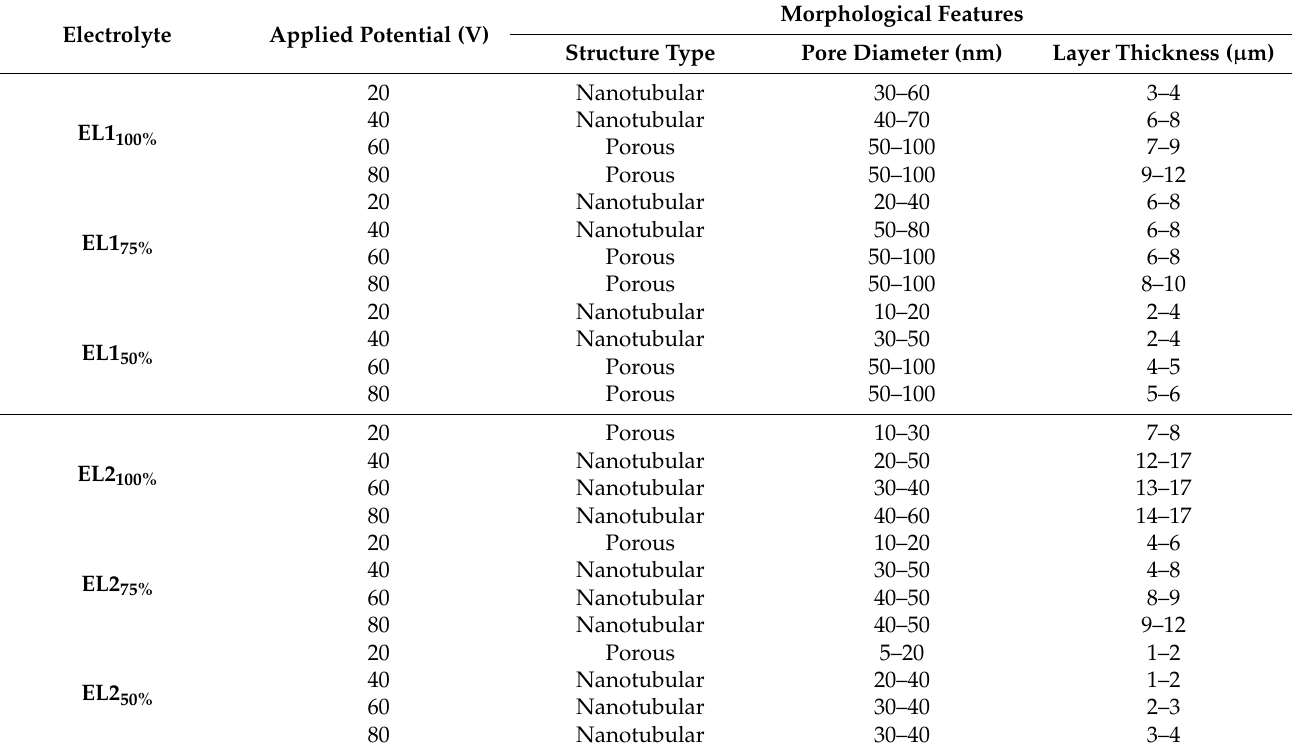
Table 2. Morphological features of the prepared TNS in different electrolytes. Electrolyte Applied Potential